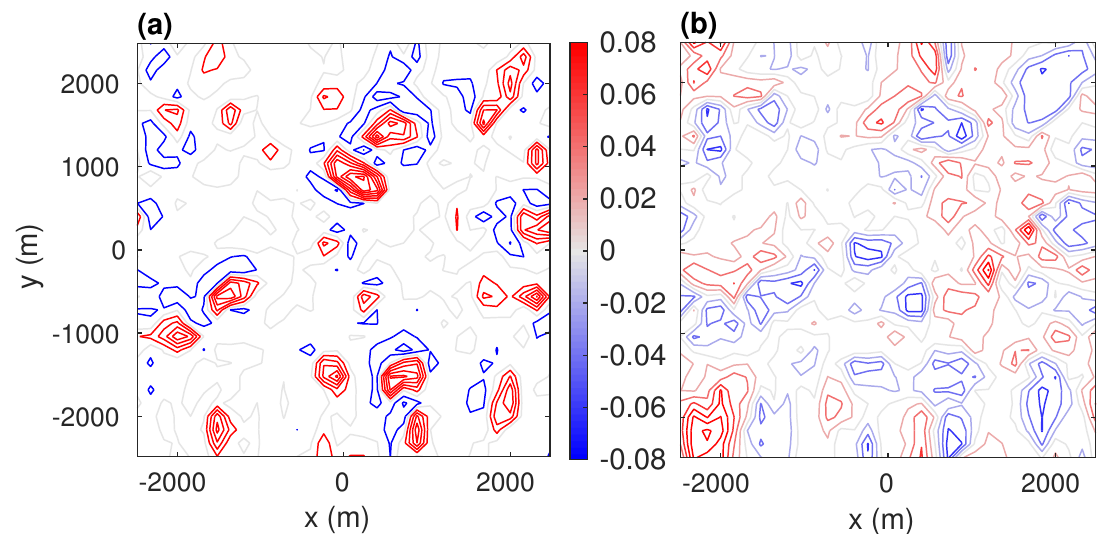
Figure 16. Horizontal cross-sections of ( a ) the vertical velocity w and ( b ) perturbation potential temperatures θ (cid:48) from the CBL1 run with grid length 160 m, at a height of 1024 m (0.83 z i ). The colour bar extends from − 0.08 to 0.08 ms − 1 in ( a ) and from − 0.08 to 0.08 K in ( b